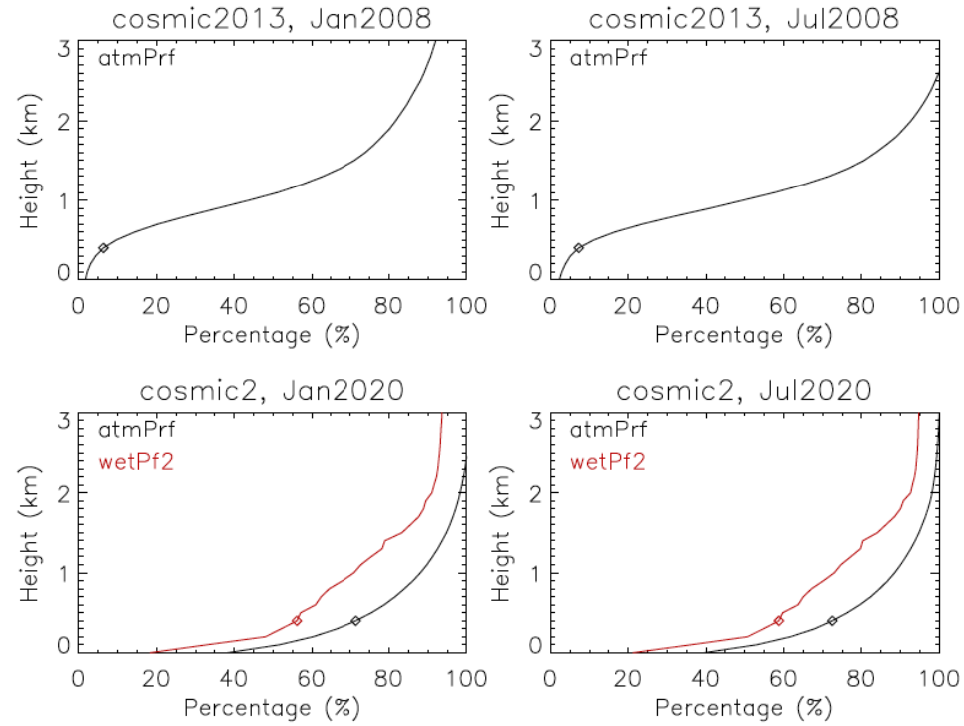
Figure 8. Comparisons of tropical (30° S–30° N) MABL penetration percentage of the Level-2 data over the Level-1B S RO from COSMIC-1 (top panel) and COSMIC-2 (bottom panel) in January and July. The 2008 (atmPrf and wetPrf) and 2020 (atmPrf and wetPf2) data are used for COSMIC-1 and COSMIC-2, respectively. Only atmPrf statistics are shown for COSMIC-1 since they are the same as wetPrf. The 400 m level is indicated by the symbol in each panel.